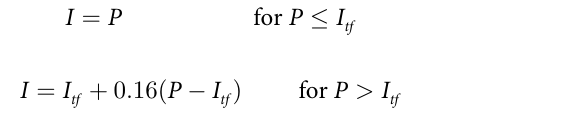
PLOS ONE | https://doi.org/10.1371/journal.pone.0271236 September 2,